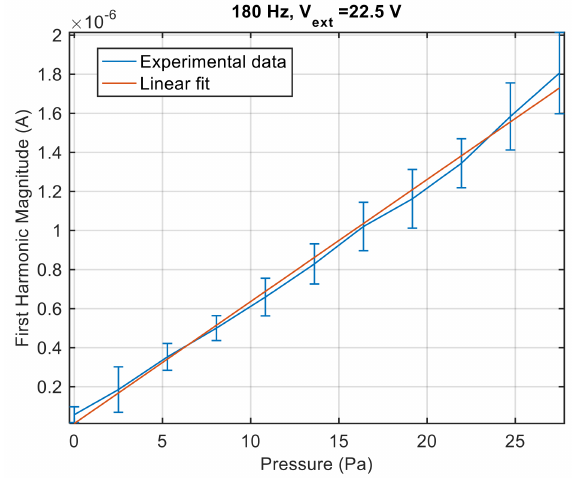
Figure 13. Peak magnitude of the ion current first harmonic as a function of the acoustic pressure at 180 Hz. V ext = 22.5 V. Measured current values are the mean values obtained from 10 repeated experiments, error bars represent the standard